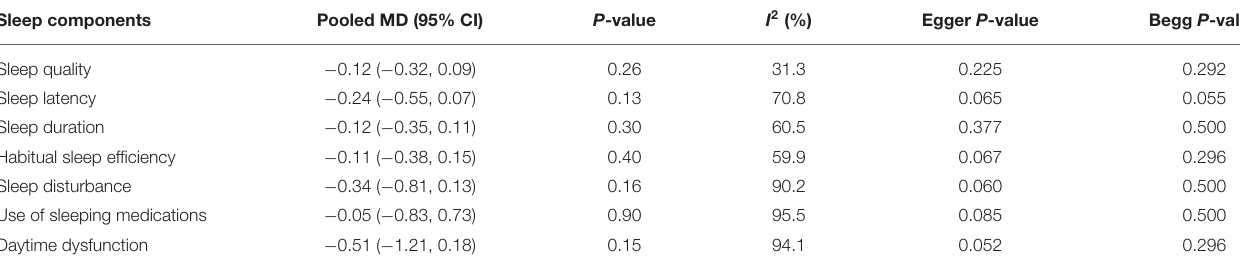
TABLE 2 | Efficacy of eye masks and/or earplugs interventions for sleep components based on PSQI. Sleep components Pooled MD (95%